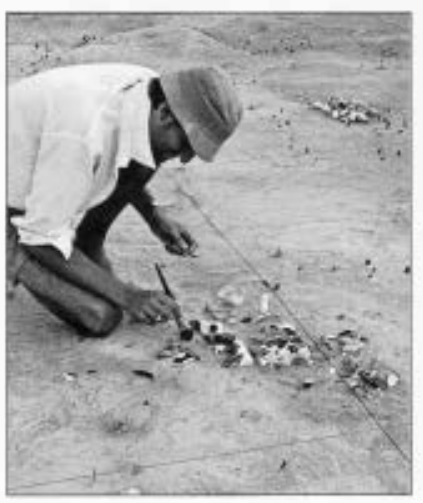
Figure 4 Excavating in situ knapping scatters at the horse butchery site